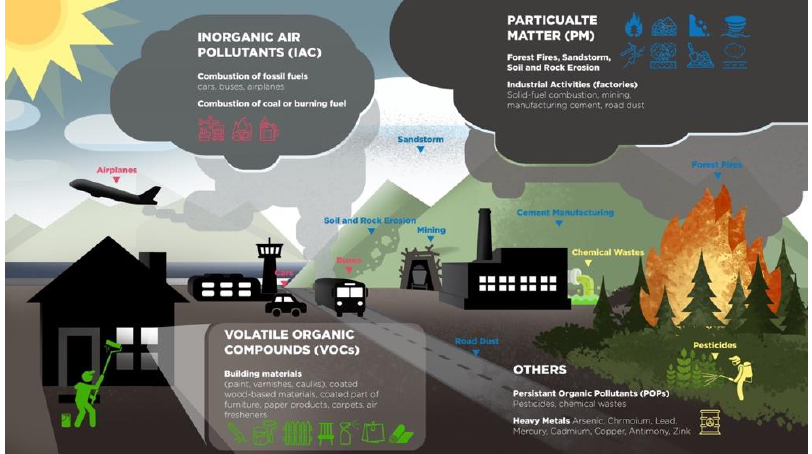
Figure 1. Schematic representation of air pollutants and their